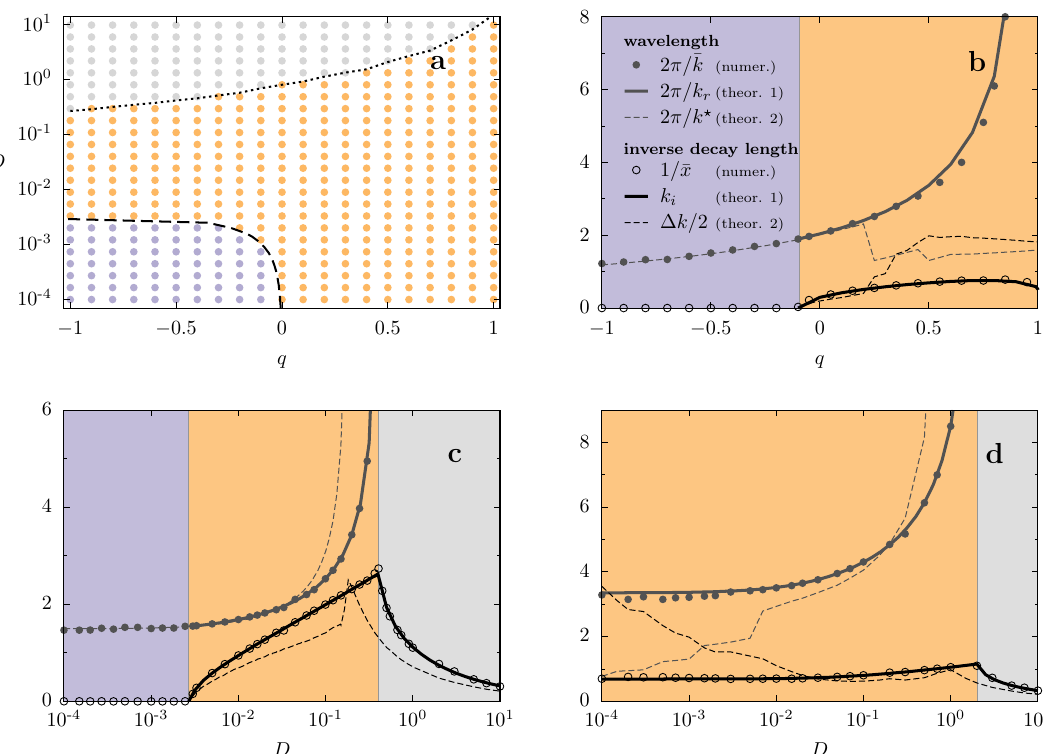
Figure 5. Phase diagram and characteristics of the stationary profiles as a function of diffusion coefficient D 2 . ( a ) Phase diagram in the q D plane, and q , in the semi-infinite habitat. We used the kernel γ q ( x ) , with ℓ = − 3 , ( c ) q 10 1 . In diagram ( a ), 0.5 ( d ) q 0.5 . The remaining parameters are a b and cuts at ( b ) D − = = = = − = x that characterize for each point in the grid, the type of regime was determined based on the values of 2 π/ ¯ k and ¯ x the solutions of Eq. (3): sustained oscillations ( ¯ k > 0 and , lilac), decaying oscillations ( ¯ k > 0 and finite ¯ → ∞ 0 and finite k x , orange), and pure exponential decay ( x , gray). In ( a ), the dashed and dotted lines correspond ¯ = ¯ ¯ (cid:31) ( k ) , with 0 and k 0 , respectively, where k to k i r = r and k i are the real and imaginary parts of the zeros of = the smallest positive imaginary part. In ( b )-( d ), symbols correspond to measurements of numerical profiles, according to Fig. 4, and solid lines correspond to the prediction in Eq. (10) (theoretical 1). Thin dashed lines correspond to the harmonic estimate (theoretical 2) given by Eq.